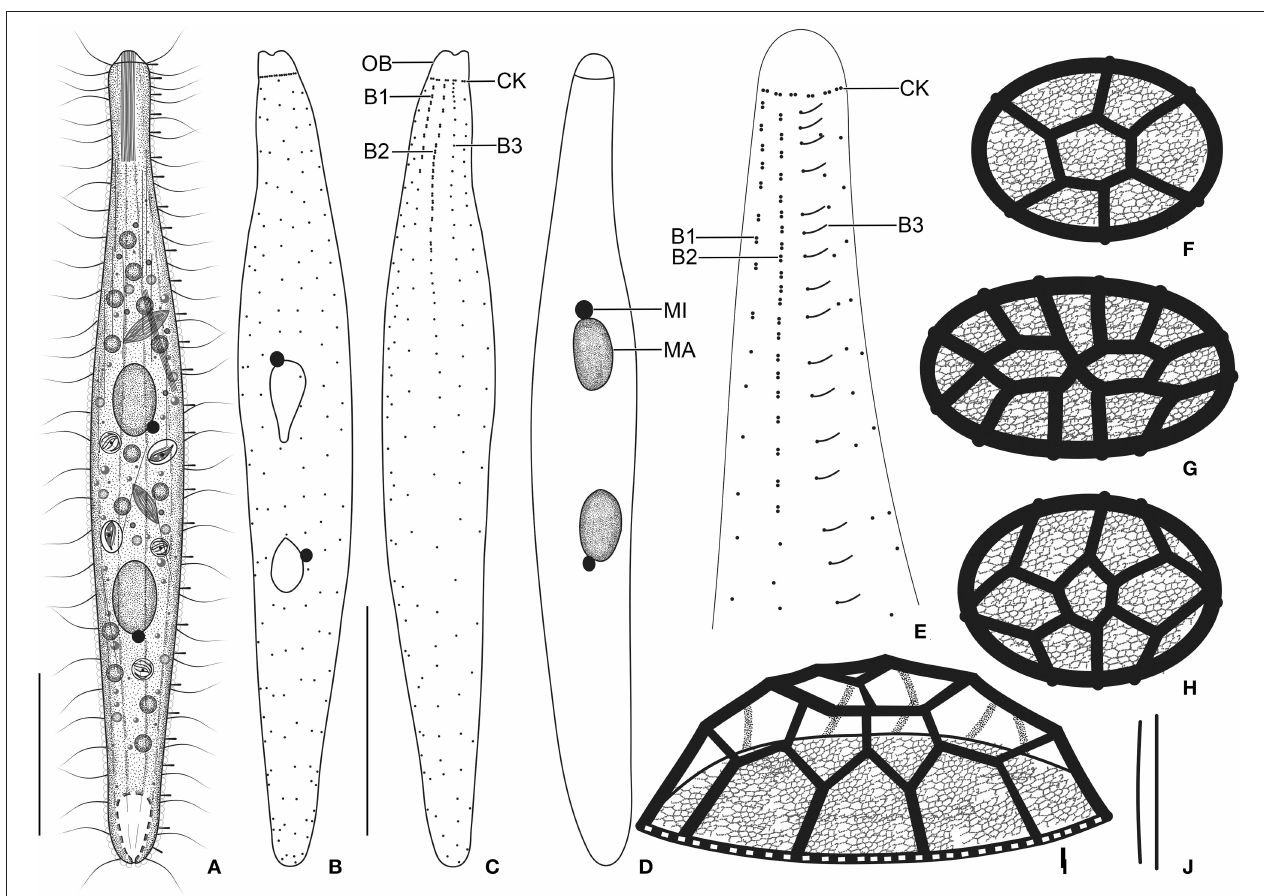
FIGURE 4 | Trachelophyllum parapiculatum sp. nov. from life (A,J) , after protargol impregnation (B–E) , and redrawn from scanning electron micrographs (F–I) . (A) A representative specimen showing the body shape and the long extrusomes in the oral bulge and cytoplasm, and the long brush row 3. (B–E) Ventral (B,D) and dorsal (C,E) views of the holotype (B,C) and two paratype (D,E) specimens, showing the somatic ciliature and the nuclear apparatus. Note the two dikinetidal brush rows, the single monokinetidal brush 3, and the dikinetidal circumoral kinety. (F–I) Surface (F–H) and lateral (I) views of lepidosomes type I. (J) Extrusomes. B1–3, dorsal brush rows; CK, circumoral kinety; MA, macronuclear nodules; MI, micronucleus; OB, oral bulge. Scale bars = 30 µ m.